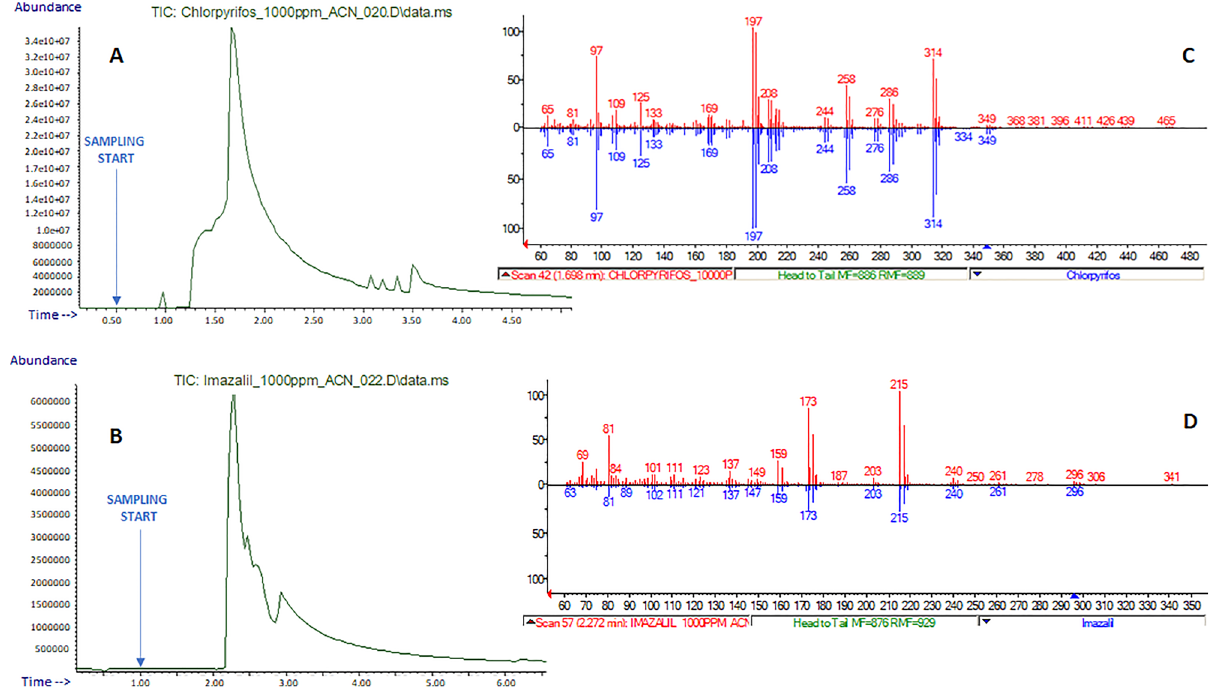
Figure 5. ( A ) Analysis of an orange peel fortified with chlorpyrifos: TIC; ( B ) analysis of an orange peel fortified with imazalil: TIC; NIST library spectra matching: red, experimental spectra for chlorpyrifos ( C ) and imazalil ( D ); blue, library spectra. The arrows indicate the sampling start.